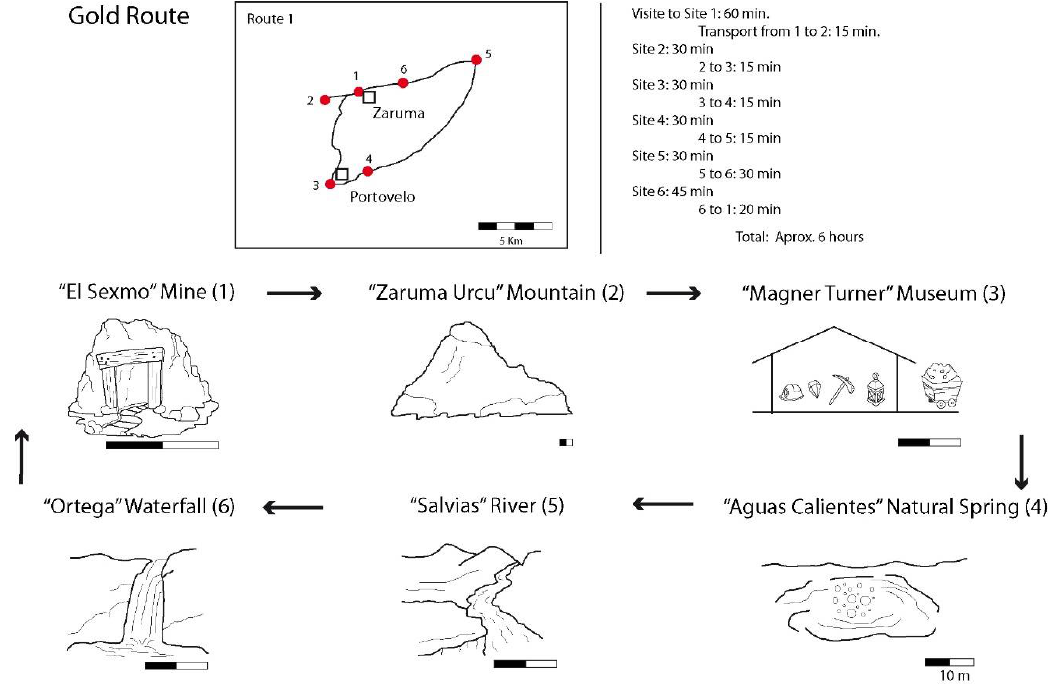
Figure 7. Suggested itinerary, within “Ruta del Oro”, selecting several geosites and mining sites. Table 8. Interest, Fr., Vul., DS, and Pp assessment in the context of the proposed route (Figure 7). Itinerary